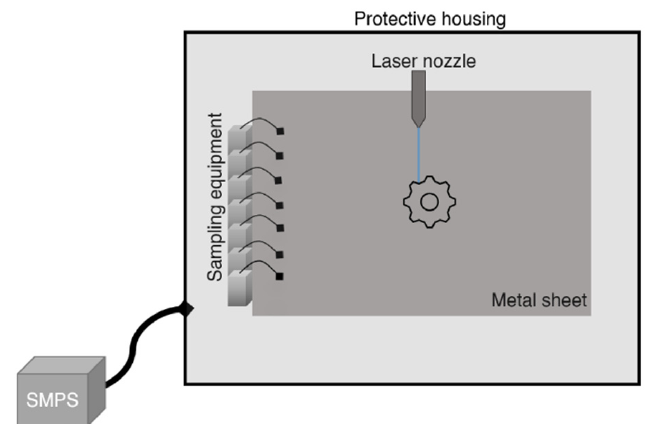
Figure 1. Scheme of the sampling equipment (total cassettes with filters and associated pumps) used during laser cutting. The antistatic tube connected to a scanning mobility particle sizer (SMPS) was attached to the inside of the protective housing.